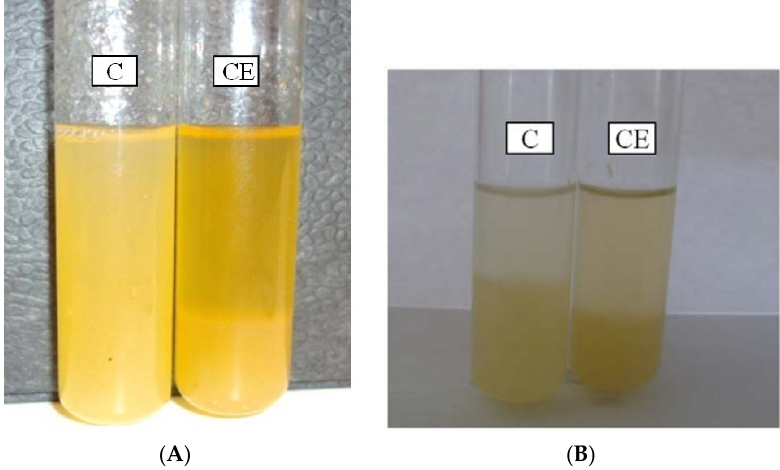
Figure 7. ( A ) Reduction of the haze of fresh citrus juice by CE (crude extracellular enzymes from A. pullulans ); C: without treatment (considered as “control”); ( B ) Reduction of the haze of fresh apple juice by CE (crude extracellular enzymes from A. pullulans ); C: without treatment (considered as “control”).